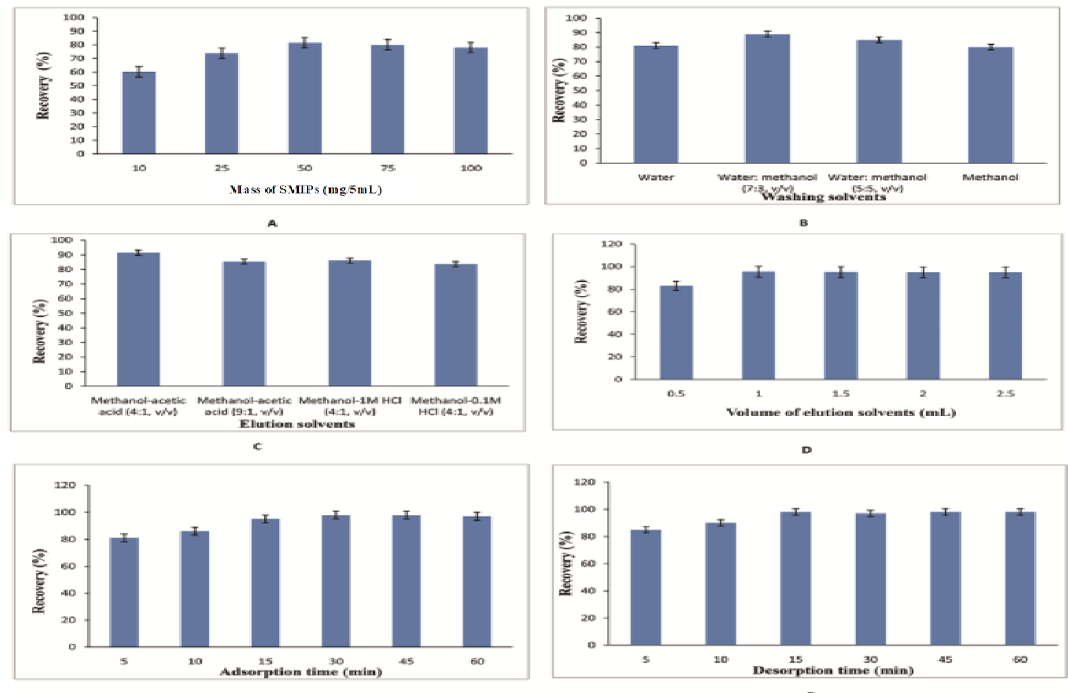
Figure 3. Optimization of DSPE procedure( A ): Amount of sorbent; ( B ): washing solvents; ( C ): elution solvents; ( D ): volume of elution solvents; ( E ): time for adsorption; ( F ): time for desorption.